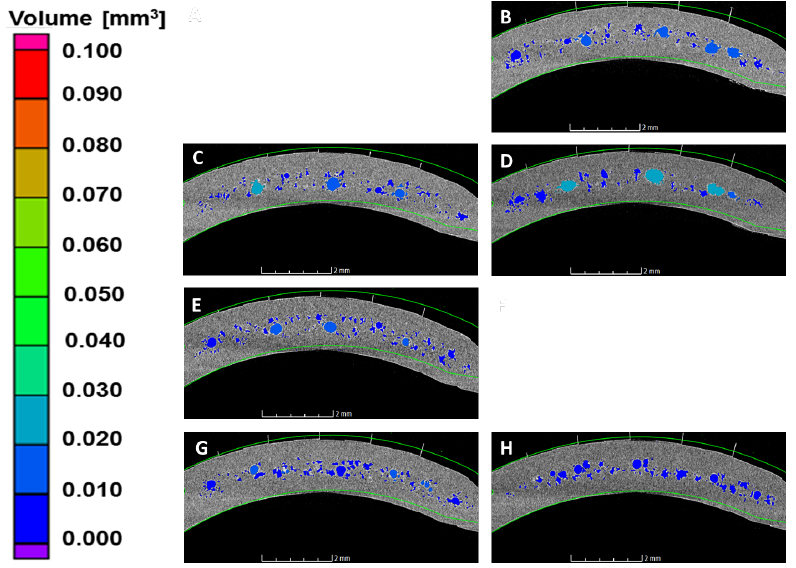
Figure 5. Cross sectional view at parting plane for process settings A to H (Table 3) at mold temperature of 120